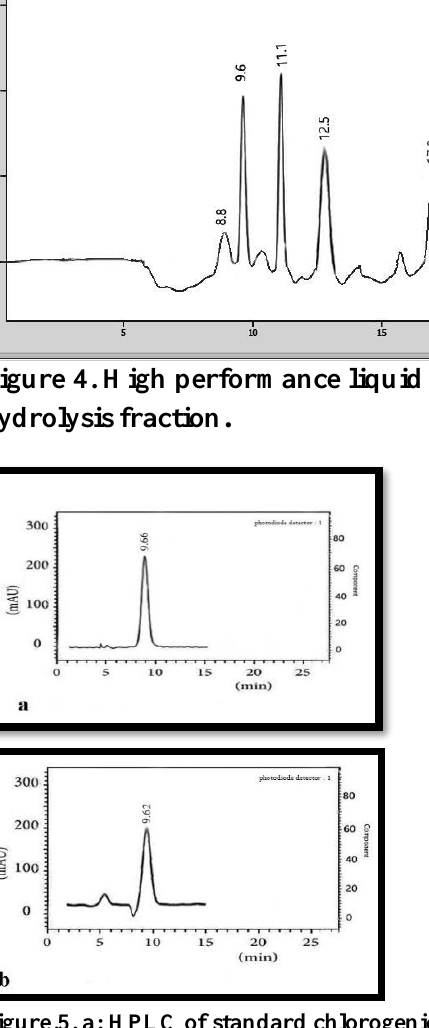
Figure 6 .a : Hplc of standard caffeic acid, b: Hplc of isolated caffeic